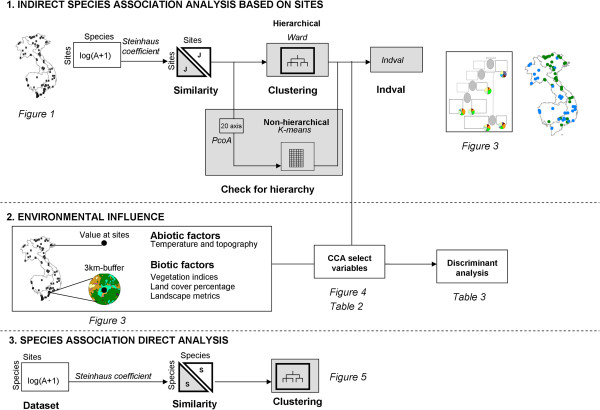
General scheme of analysis.